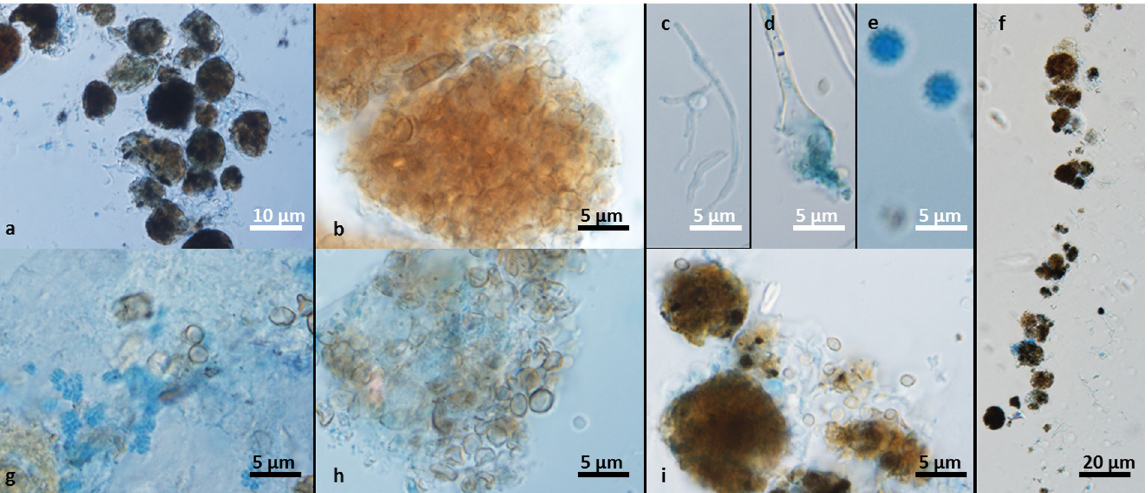
Fig 3. Representative samples from biofilm formed on dishwasher rubber seal. (a-f) Dehydrated biofilm. (a, b, f) In-vivo morphology (muriform cells embedded in extracellular polymeric substance (EPS)) from a biofilm on a dried rubber dishwasher seal from which E . dermatitidis genotypes A and C were isolated. (c-e) Structures of filamentous fungi after desiccation show Fusarium spp. (c) , Aspergillus spp. (d) and spores (e) . (g-i) Hydrated biofilm. Co-culture of bacteria and fungi (g) , clusters of yeast cells covered with EPS, with additional individual cells that spread during the washing cycle (h) , and muriform cells of E . dermatitidis genotype A with fungal hyphae (i)